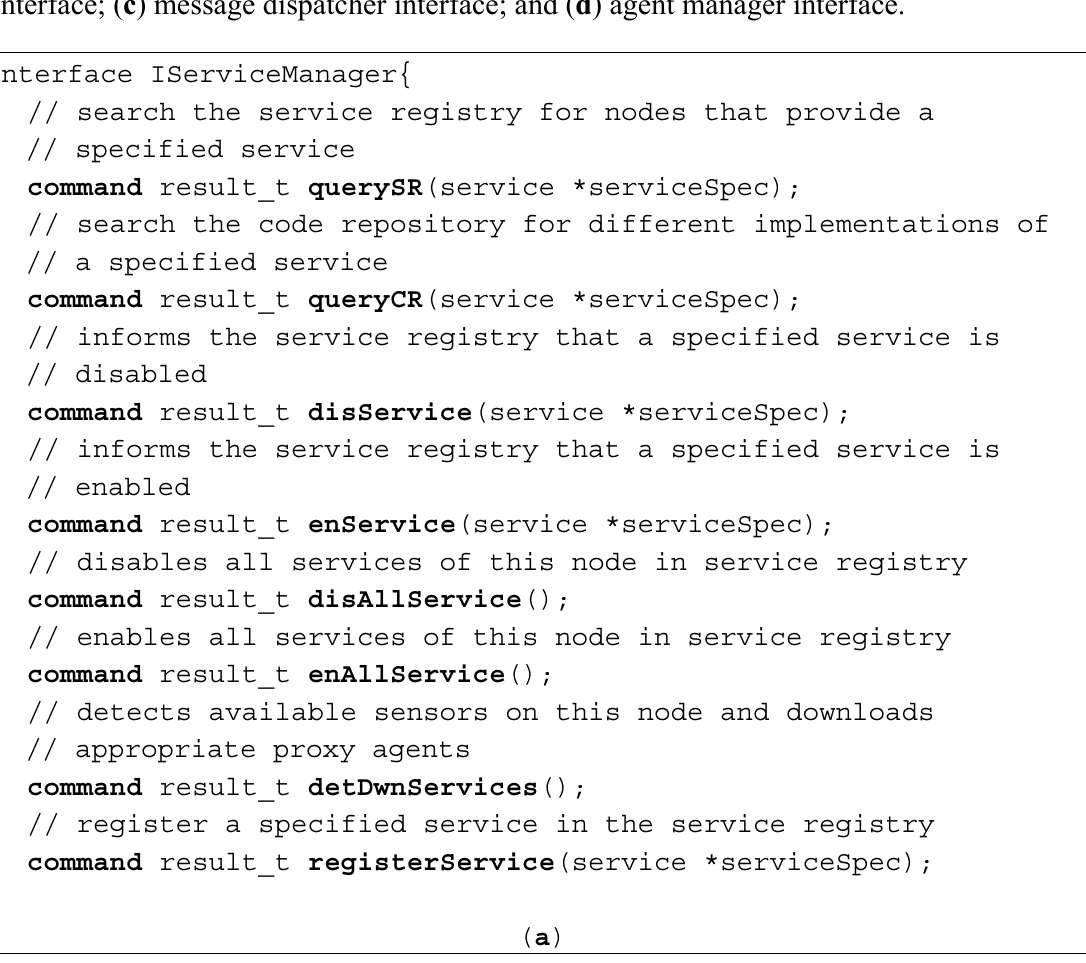
Figure 8. Key interfaces of SOMM ( a ) service manager interface; ( b ) QoS aware routing interface; ( c ) message dispatcher interface; and ( d ) agent manager